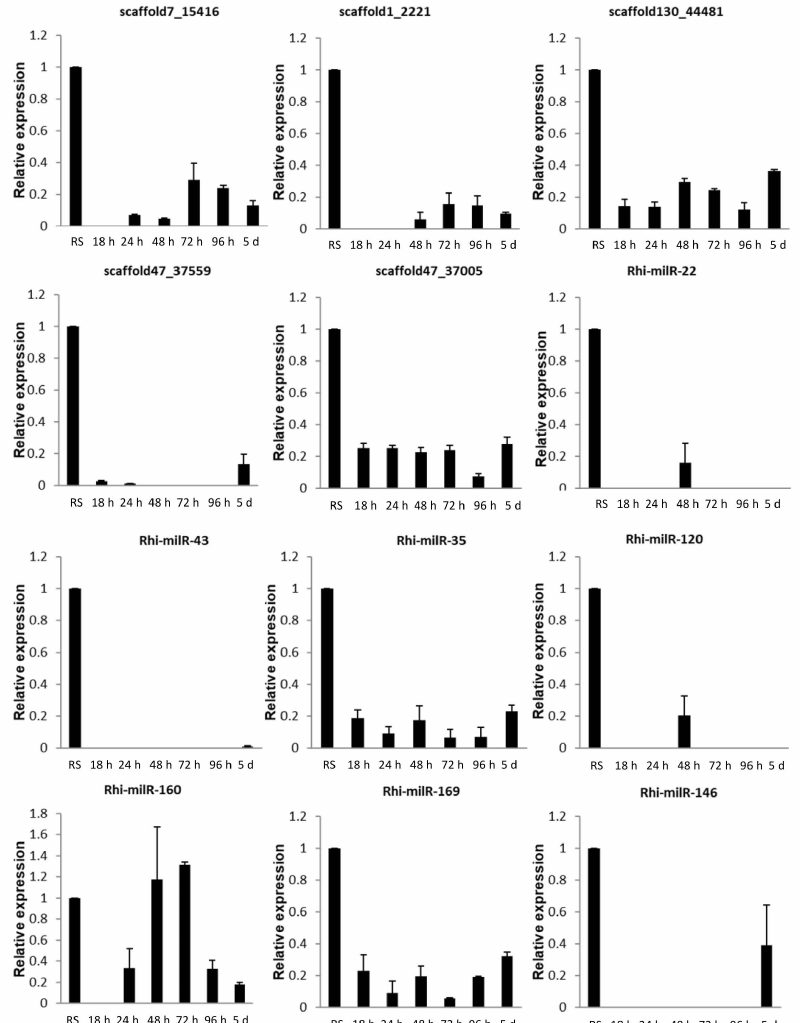
Figure 2. qRT-PCR expression analysis of milRNAs at different time points after fungal inoculation. X-axis: samples (RS: R. solani cultured in potato dextrose agar medium, 18 h to 5 d: R. solani inoculated sheath tissue of TN1 harvested at different time points); Y-axis: Expression level of the individual milRNA relative to its expression in R. solani grown in PDA. Error bars indicate the mean ± S.E. of three biological